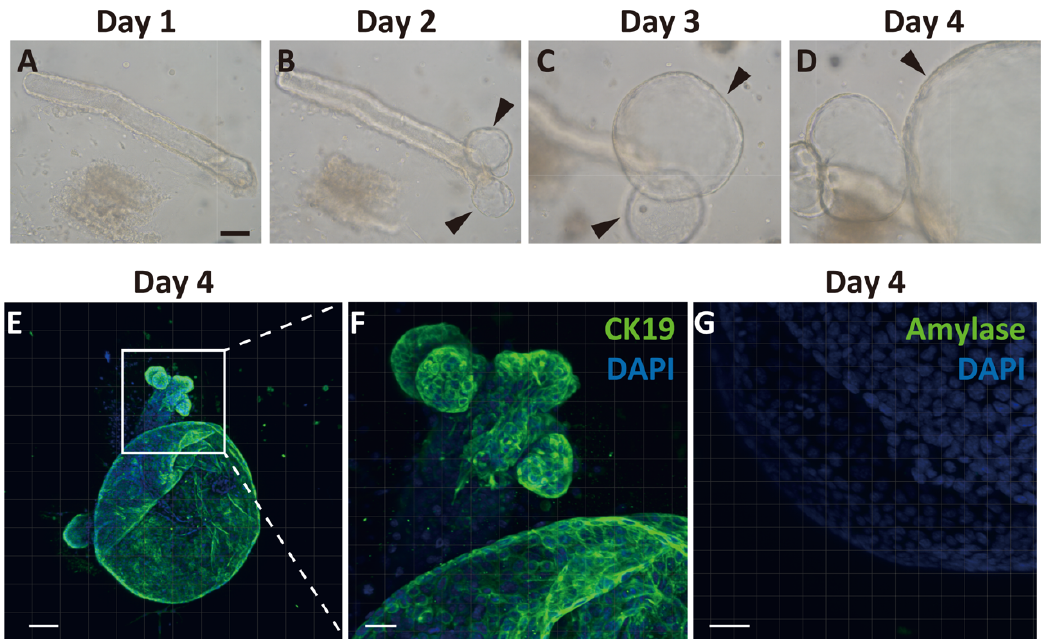
Figure 2. Generation and characterization of ductal organoid from the pancreas. Pancreatic ducts were dissected from the pancreas and embedded in Matrigel covered with organoid media to start organoid culture ( A ). After 2 days, the sheared end of the duct started proliferating and then formed organoids ( B – D , arrowheads). Immunohistochemical analysis of organoids after 4 days of culture. All cells within the organoids expressed cytokeratin 19 (CK19), a selective ductal marker ( E , F ). An acinar cell-specific marker, amylase, was not detected on day 4 ( G ). (bars: A – D , 500 µm; E , 100 µm; F , 50 µm; G , 30 µm).